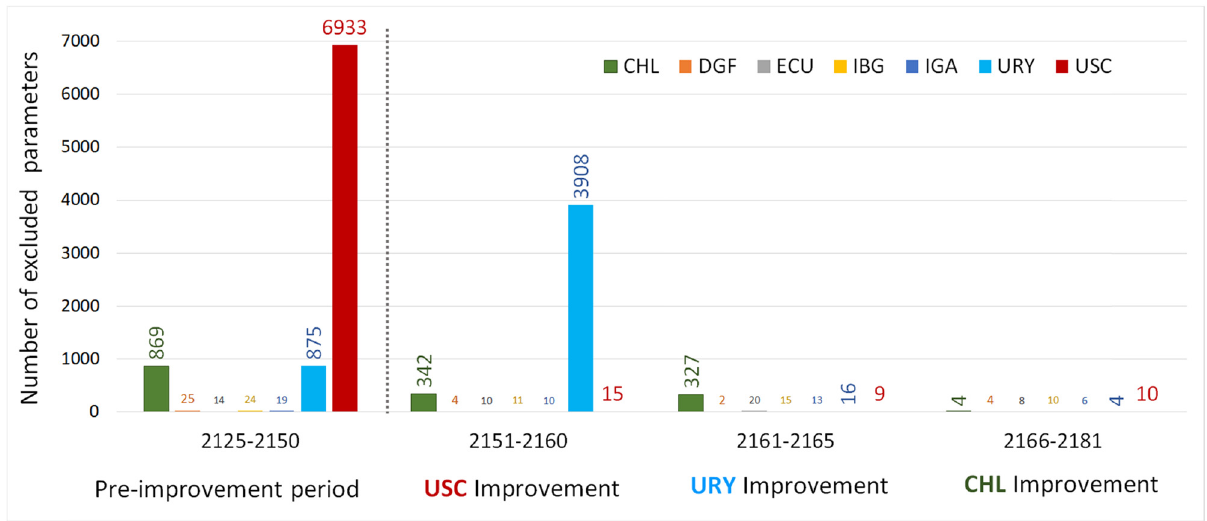
Figure 5: Number of tropospheric parameters excluded ( σ ZTD i > 0.02 m ) , per week, per AC, during improvement process (